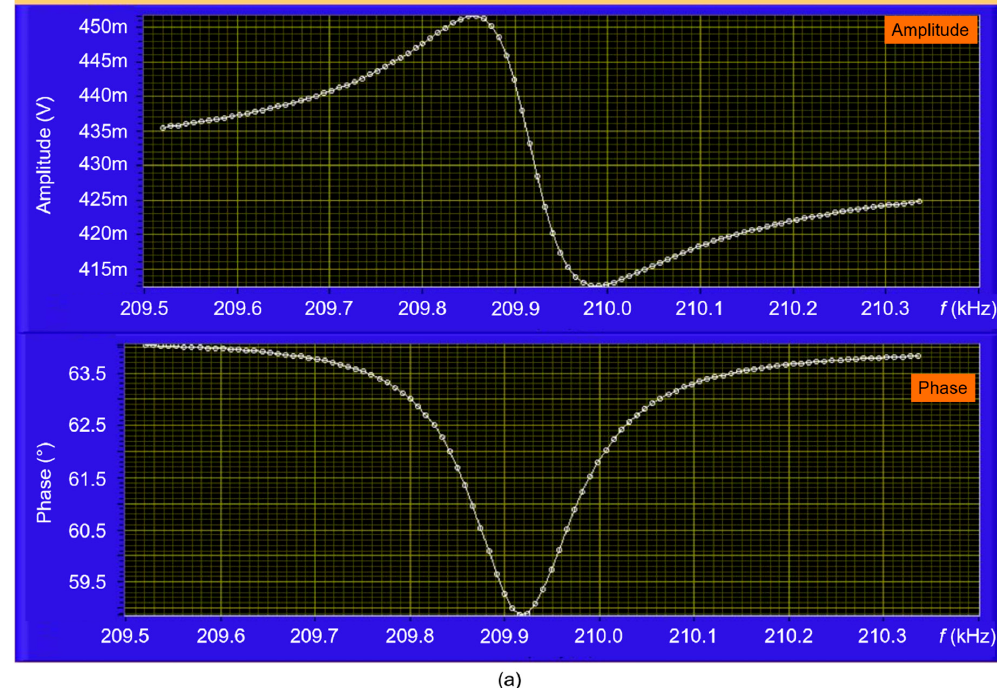
Figure 3. A LabVIEW-based user interface to execute a frequency sweep around the observed resonance mode of the EtPCS. Reference parameters of 0.43 V amplitude and 63.9° phase with the Fano resonance ( a ) are calculated to yield an optimized frequency response ( b ), i.e., a symmetrical amplitude shape and a monotonic phase transition.